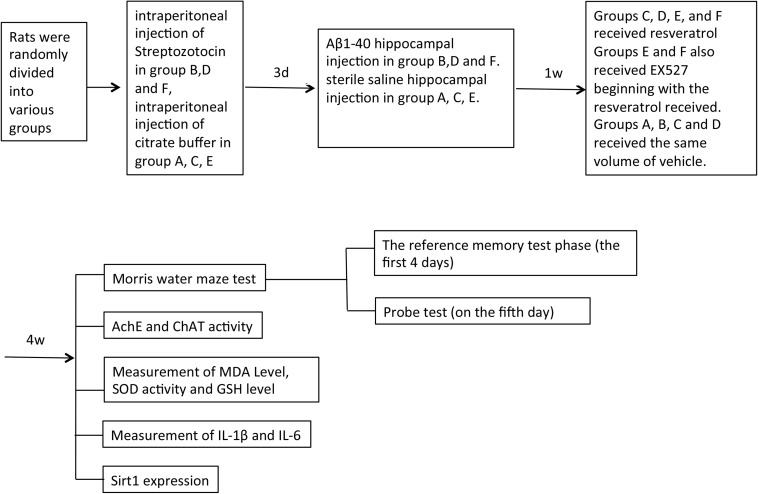
Experiment flow chart.